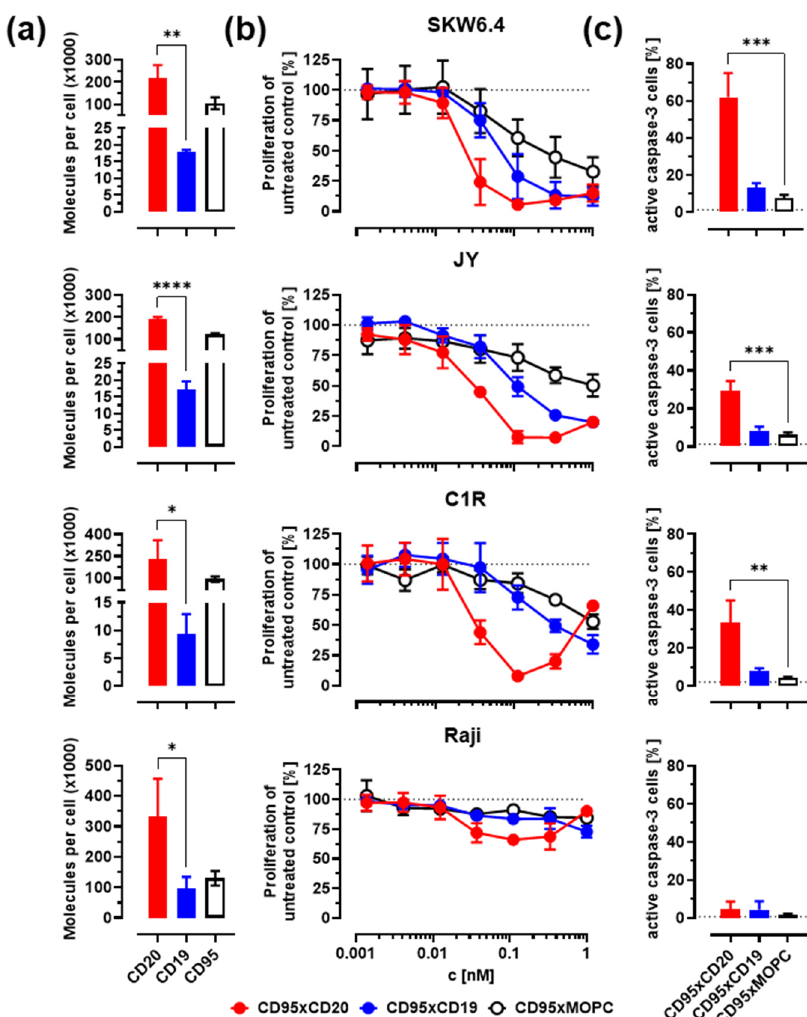
Figure 2. Bispecific CD95 antibodies induce depletion of lymphoma cells via apoptosis. The target antigen-mediated induction of apoptosis was evaluated on SKW6.4, JY, C1R, and Raji cells. ( a ) The antigen density of CD95, CD20, and CD19 on the cell surface of different cell lines was calculated